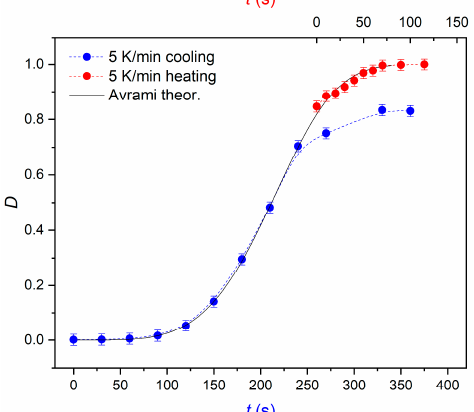
Figure3. Timeevolutionofthecrystallinitydegree D (t)observedbyPOMoncooling(partialcrystallization) Figure 3. Time evolution of the crystallinity degree D(t) observed by POM on cooling (partial and heating at the rate of 5 K / min. The black line denotes the theoretically-predicted Avrami crystallization) and heating at the rate of 5 K/min. The black line denotes the theoretically-predicted Avrami curve.